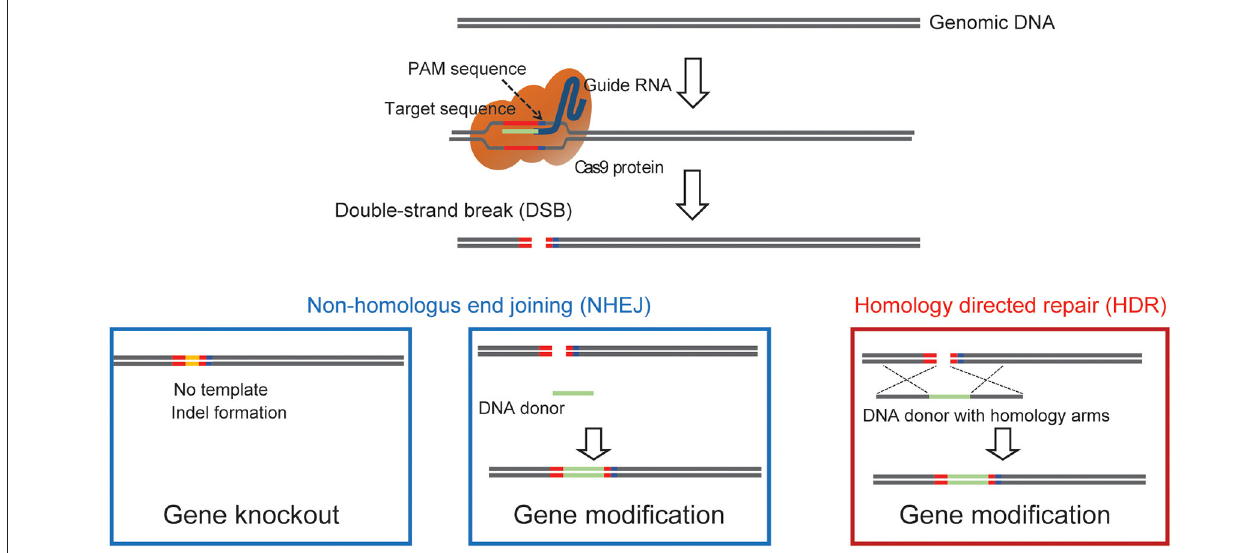
FIGURE 1 | A diagram showing how Cas9 can achieve precise double strand genomic DNA break. The diagram illustrates the use of Cas9 double-strand break to induce gene, NHEJ mediated knockin to label endogenous proteins, and HDR mediated precise knock-in of endogenous proteins.